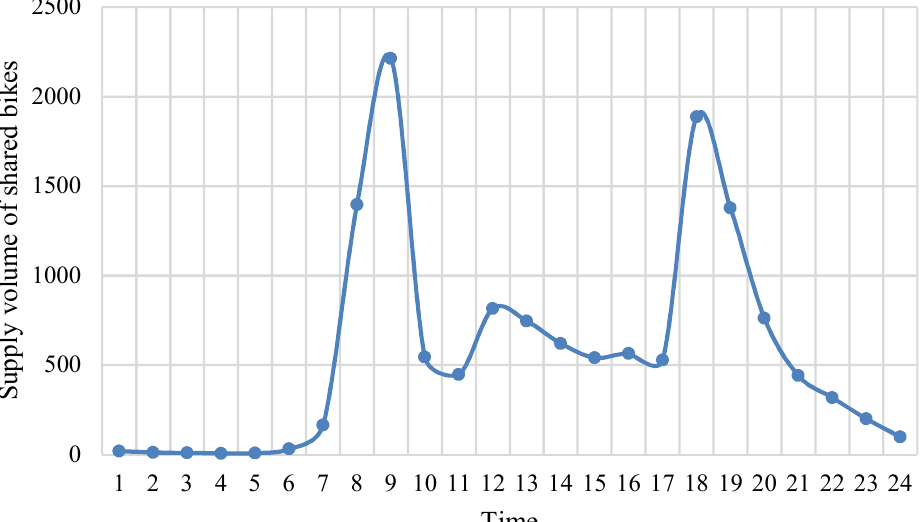
Figure 1. Supply volume for 24 h in TAZ 48.